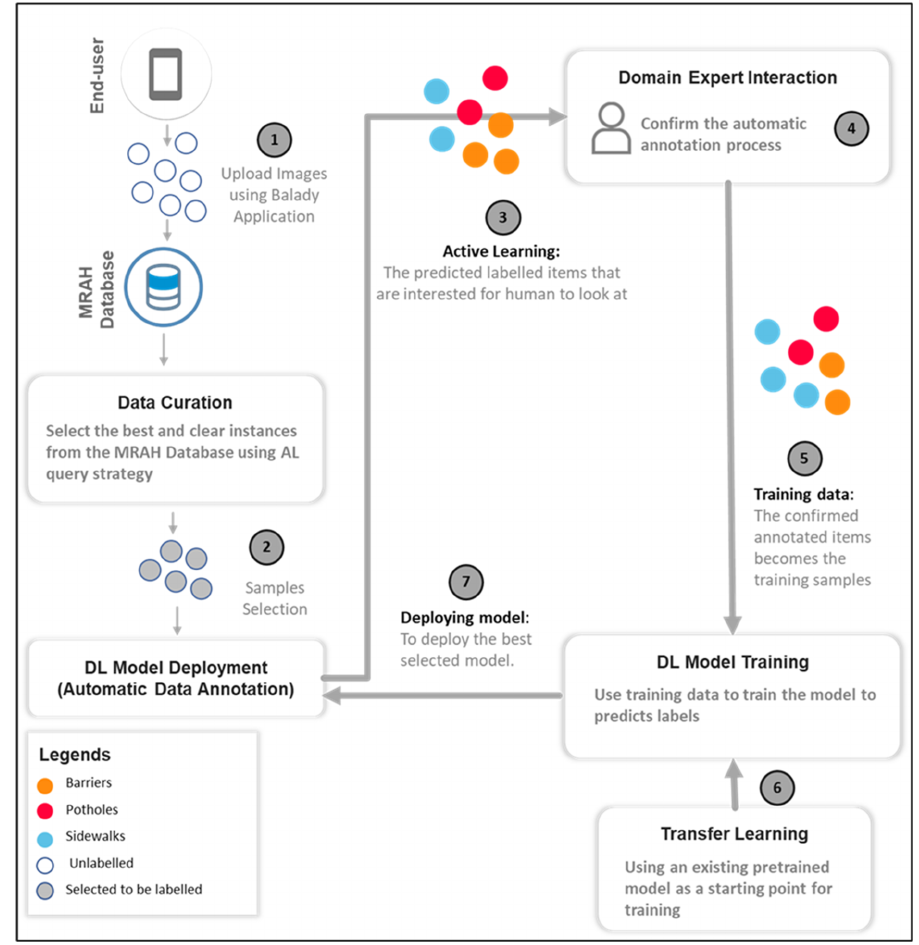
Figure 6. Deep active learning (DAL) strategy for the automatic data annotation process.